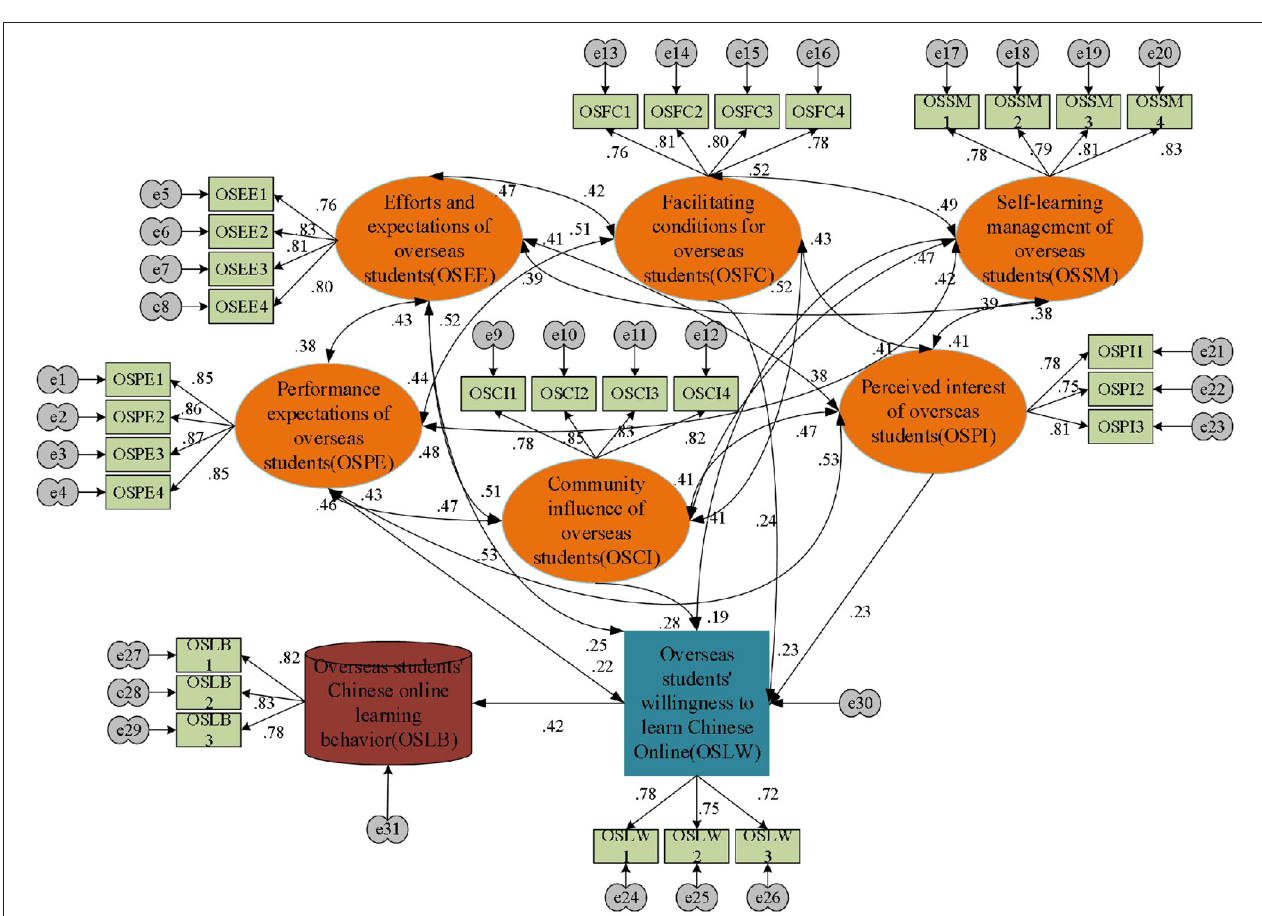
FIGURE 5 | Standardized path coefficient of the initial